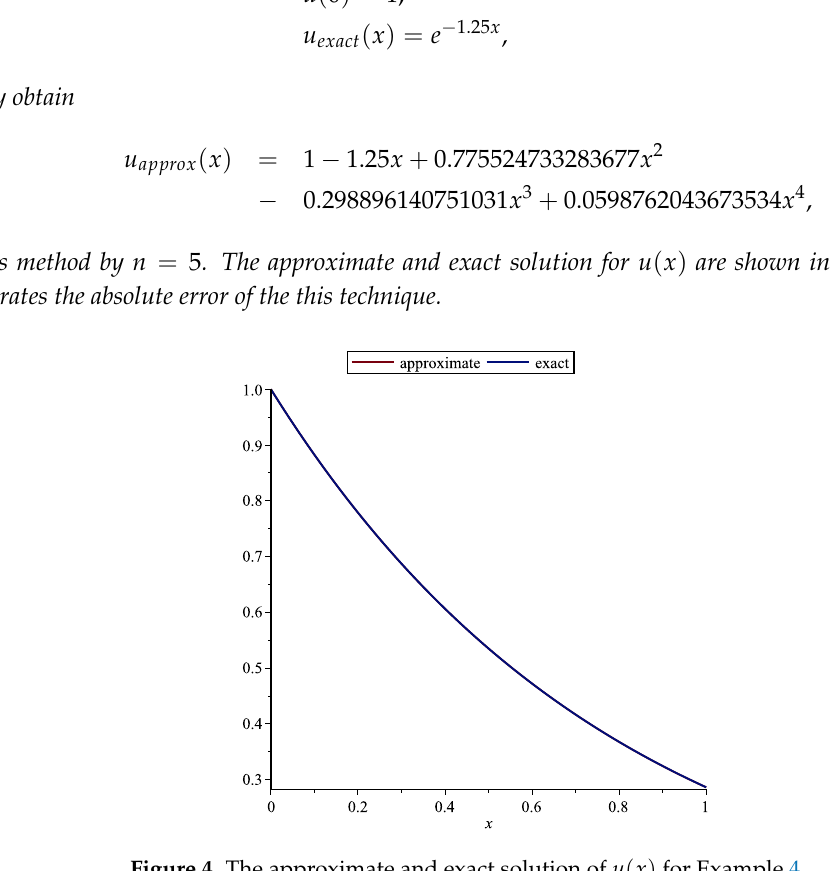
Figure 4. The approximate and exact solution of u ( x ) for Example 4. Table 4. The absolute error of the this method for Example